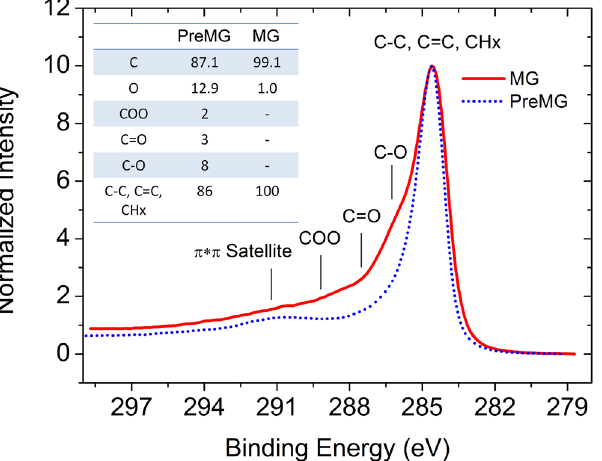
Figure 6. XPS characterization of PreMG and MG. The inset graph is the quantitative analysis of elemental and functional groups at the surface.